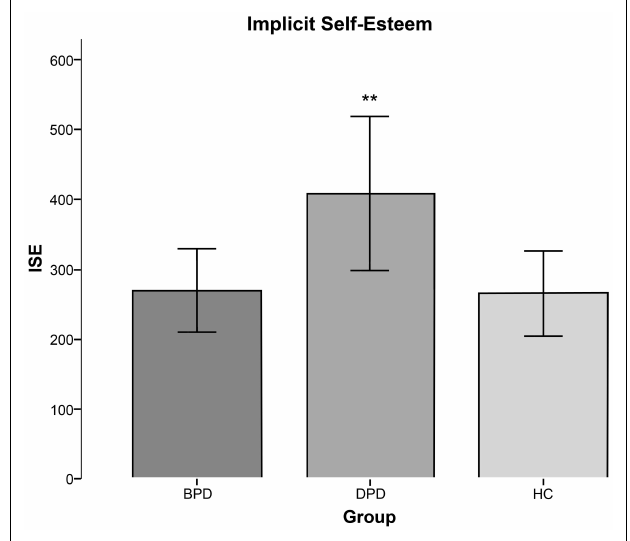
FIGURE 1 | Graph of mean ISE scores ( ± SE) by group. DPD participants had significantly higher implicit self-esteem than both BPD and HC participants. * p < 0.05, ** p < 0.01, and *** p < 0.001 with respect to healthy